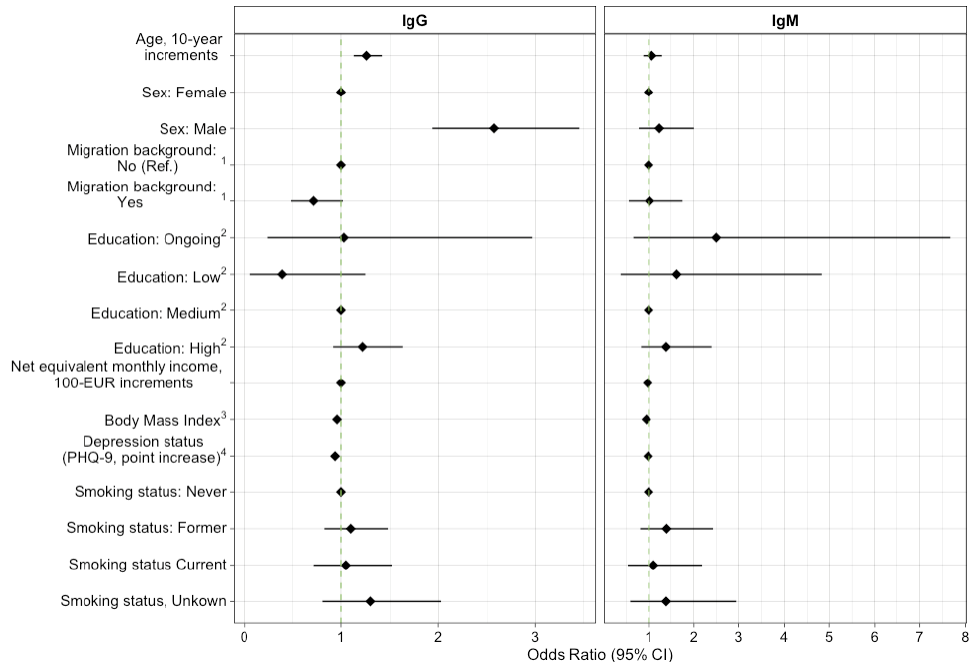
Figure 3. Odds ratios for IgG/IgM seropositivity from logistic regression. IgG = Immunoglobulin G; IgM = Immunoglobulin M; Ref. = reference; CI = confidence interval; Observations = 8009. We considered a sample as seropositive for Borrelia burgdorferi s.l. with positive or equivocal ELISA and subsequent positive immunoblot result (MiQ12) [33]; 1 Migration derived from a minimum set of indicators by Schenk et al. [44]; 2 Education level derived according to ISCED97 [45]; 3